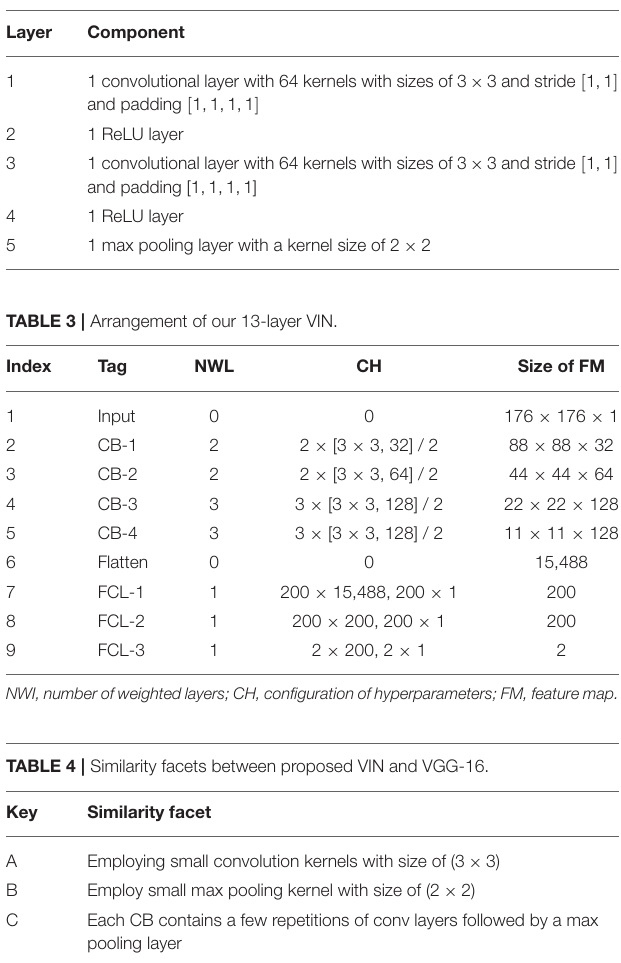
( 64 3 3 ) / 2” in VGG_16. × ×